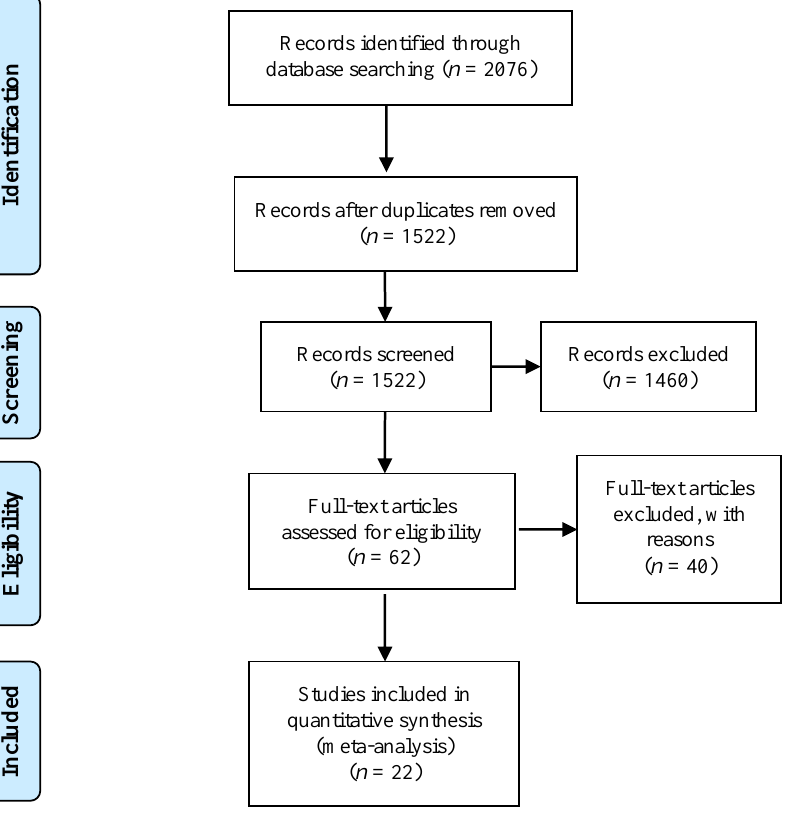
Figure 1. Flow diagram of meta-analysis. The figure shows the entire flow of studies selection (from [12]). Table 1. Studies included in the meta-analysis. The table shows the main characteristics of the studies included in the meta-analysis.